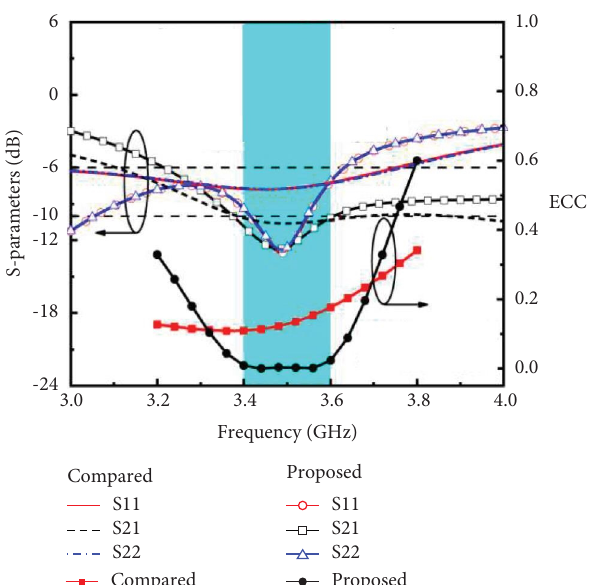
Figure 4: Simulated S -parameters and ECC of the proposed dual-port microstrip antenna pair fed by a similar π -shaped structure and the compared dual microstrip antenna pair fed by feeding structure with the connecting line.